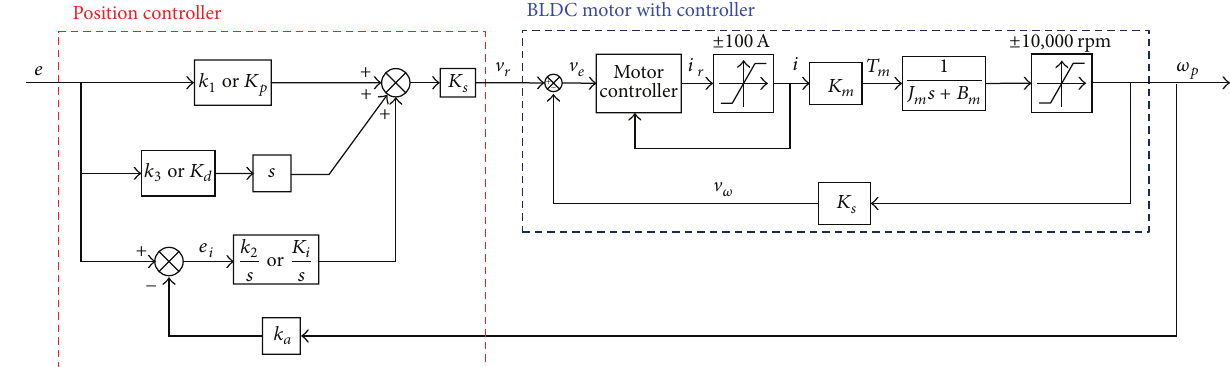
Figure 9: Block diagram for adopted antiwindup algorithm in controller design.